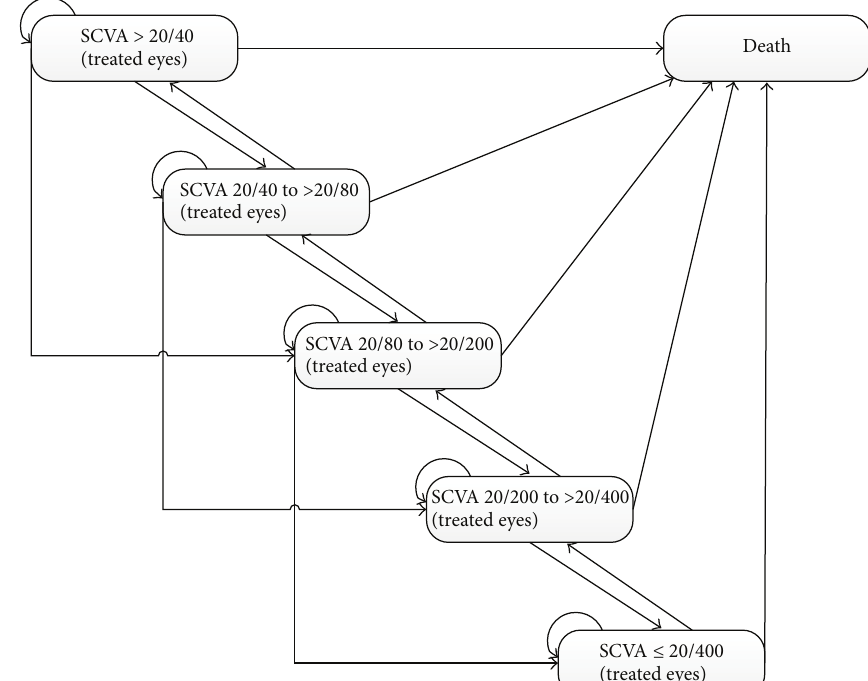
Figure 1: Overview of the Markov model structure. Health states are defined by Snellen chart visual acuity (SCVA) in the treated eye. Patients have a risk of death at any state in the